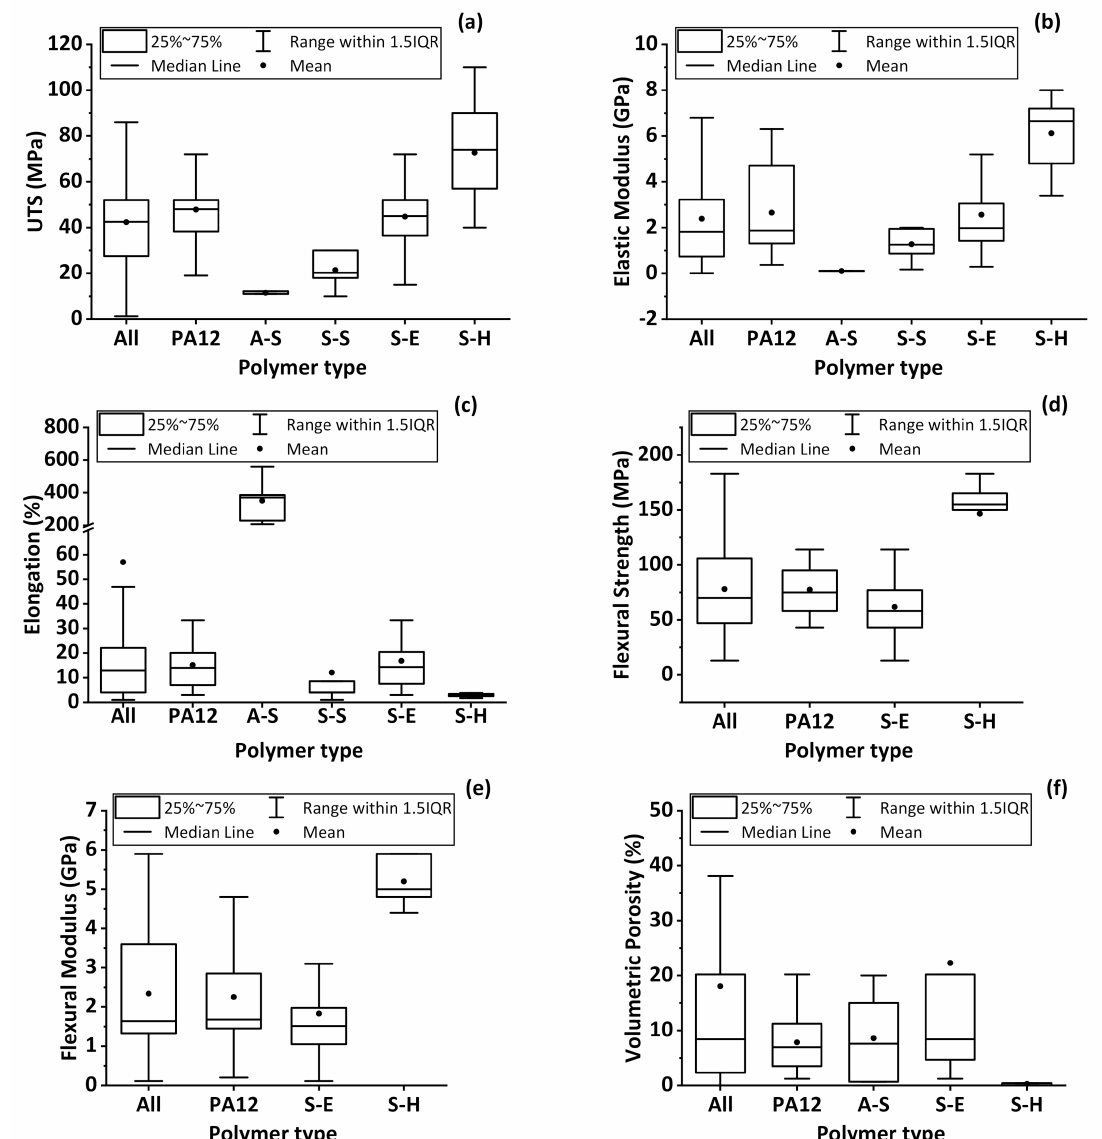
Figure 12. Statistics of the most reported as-built part properties of all polymers, PA12, A-S, S-S, S-E, and S-H powder feedstocks processed by L-PBF process: ( a ) ultimate tensile strength, ( b ) elastic modulus, ( c ) elongation, ( d ) flexural strength, ( e ) flexural modulus, and ( f ) volumetric porosity. Outlier points are not